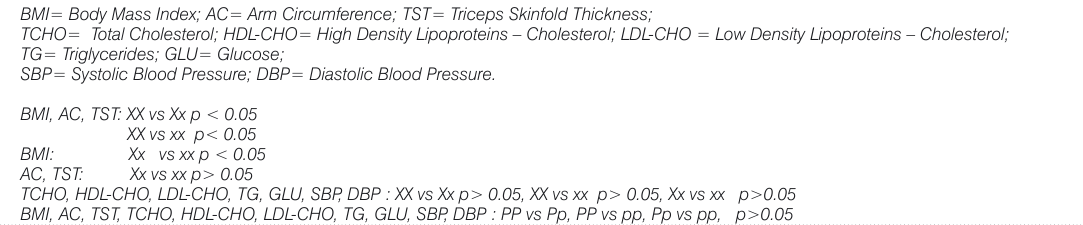
Fifty to eighty percent of obesity is determined by genetic factors